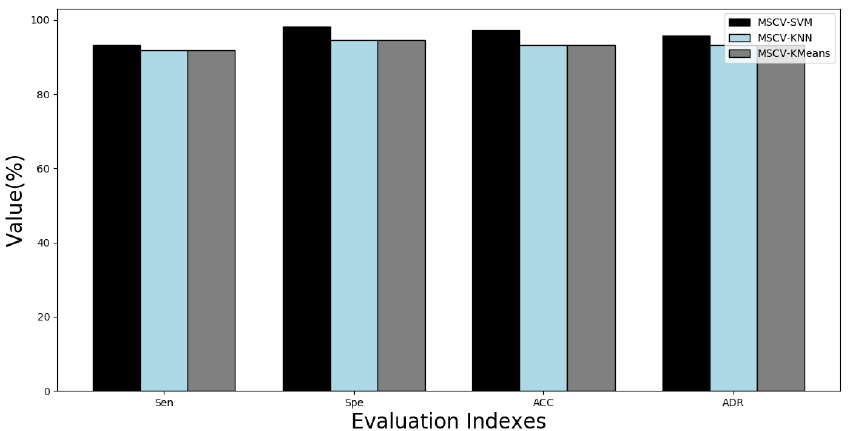
Figure 3. Comparison of four assessment indices for thirteen patients using the MCSV method employing K-Means, k-NN, and SVM as classifiers.